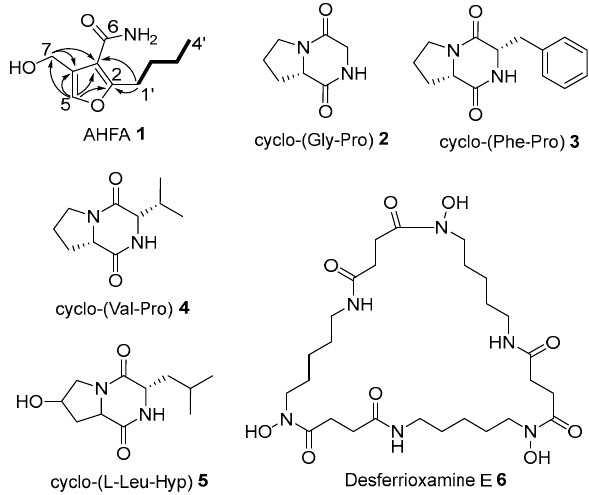
Figure 1. Isolated metabolites from Streptomyces sp. RK44. structures of which were elucidated by NMR. Structure of AHFA 1 with COSY ( — ) and key HMBC ( → ) correlations.